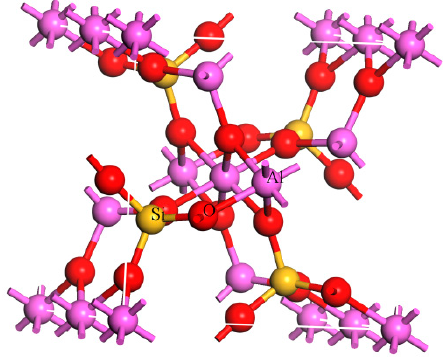
Figure 1. Bulk lattice structure of sillimanite (Atom color: pink = Al, red = O, yellow = Si).